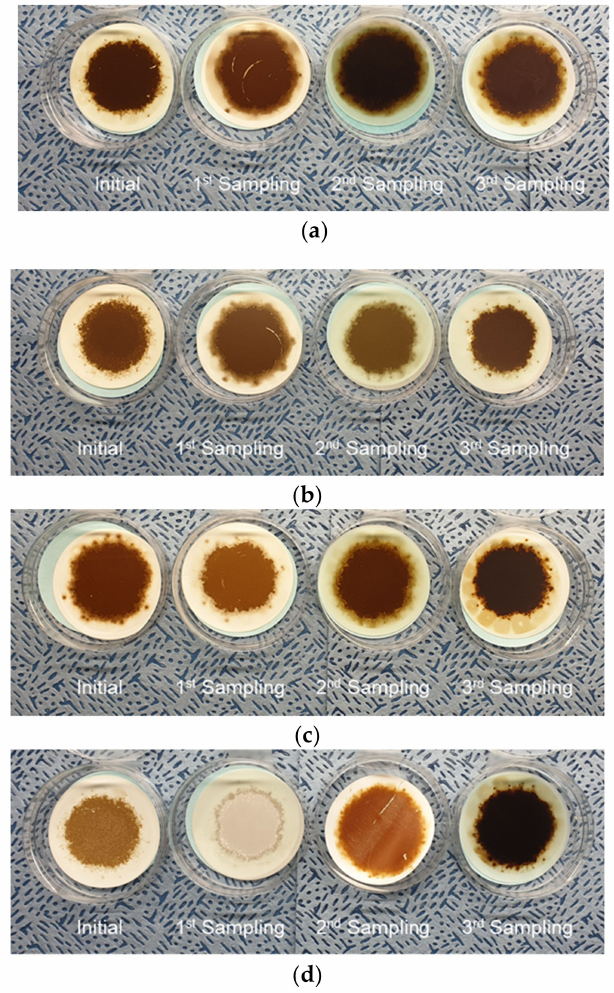
Figure 14. Sample of the MPC varnish potential test. ( a ) Monitoring A. ( b ) Monitoring B. ( c ) Monitoring C. ( d ) Monitoring